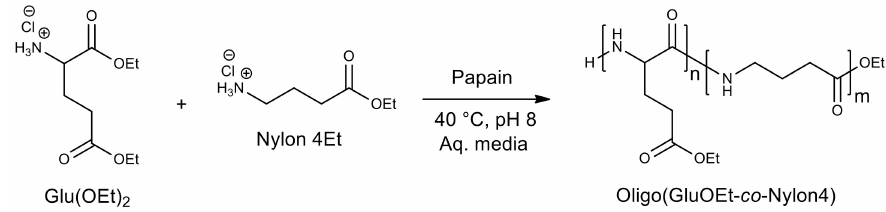
Figure 12. Synthesis of a copolymer of glutamic acid ethyl ester and nylon 4 using